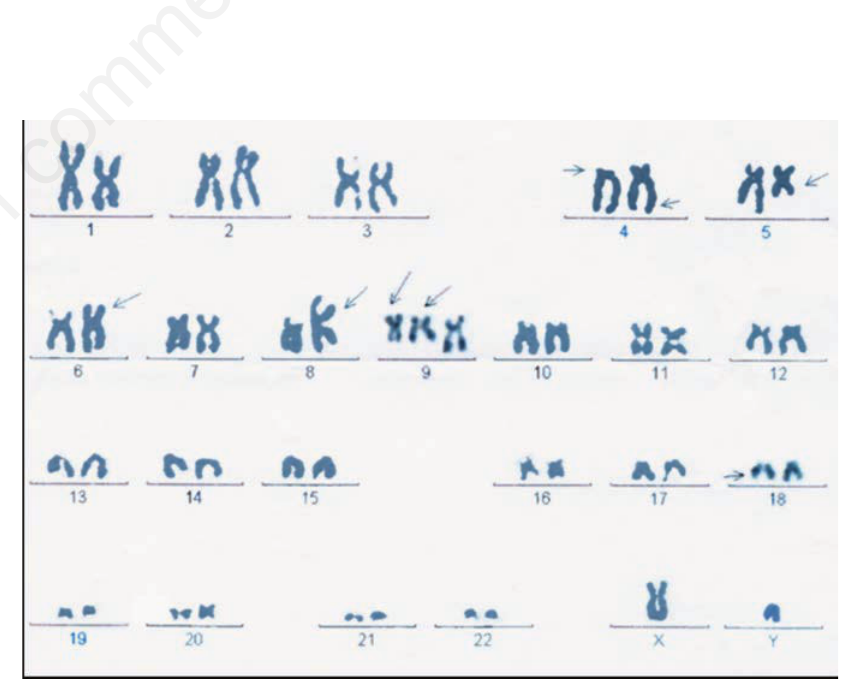
Figure 1. Morphological and Immunohistochemistry findings of bone marrow. A) Bone marrow aspirate with erythroid precursors and many proerythroblasts (arrow). The ery- throblasts are medium with scant cytoplasm, high nuclear to cytoplasmic ratio, round nuclei with fine chromatins and 1-2 prominent nucleoli. B) Bone marrow biopsy is hypercellular and packed with monotonous leukemic infiltrate composed of primitive looking blasts. (H&E,×100).C) Proerythroblasts are strongly positive for E-cadherin. D) Glycophorin A shows weak positivity.